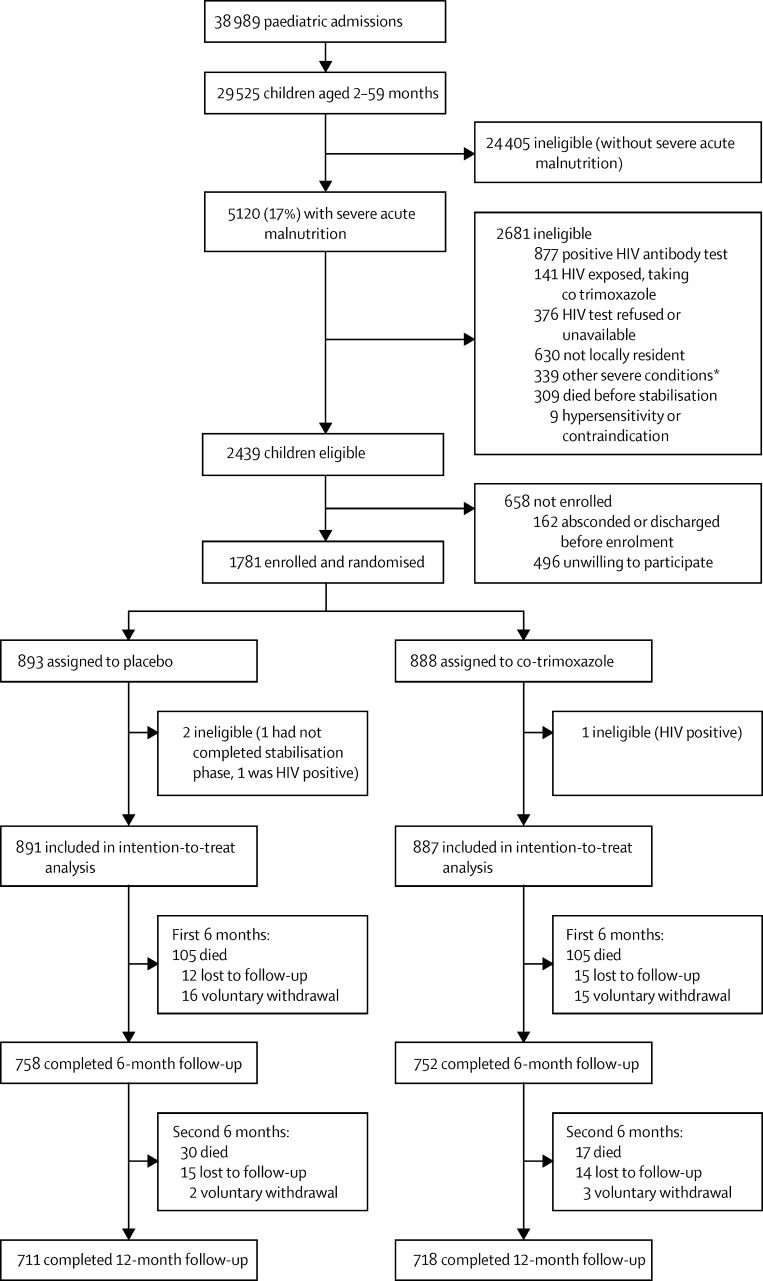
Trial profile*Includes severe congenital or acquired heart disease, malignancy, or probably terminal illness.